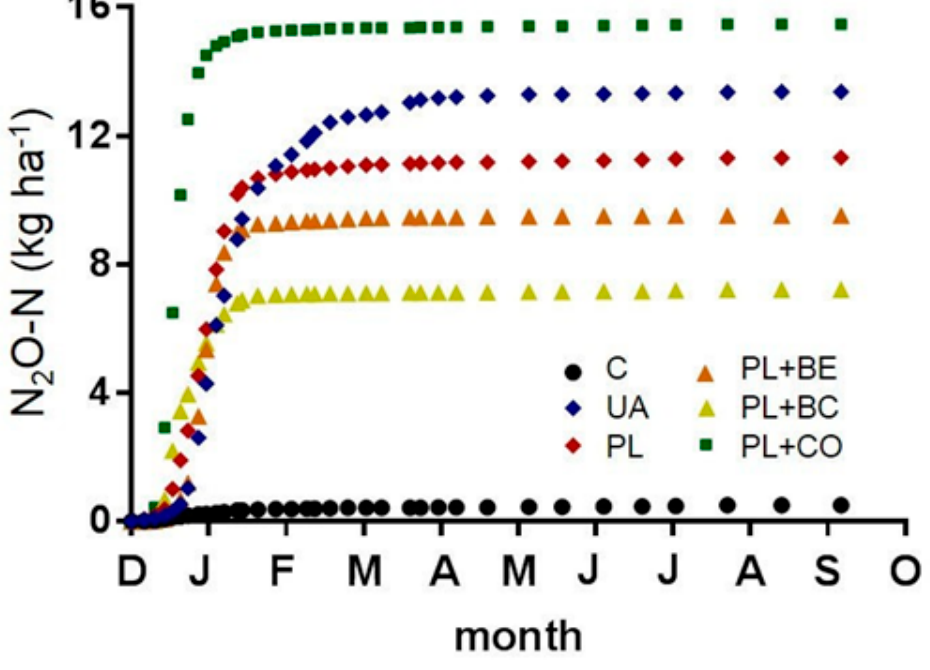
Figure 4. Mean cumulative N 2 O fluxes (kg ha kg − 1 ; n = 3) at the experimental field site from December 2014 to September 2015. C control (no N added), UA urea mineral fertiliser, PL poultry litter, PL + BE poultry litter + bentonite, PL + BC poultry litter + biochar, PL + CO poultry litter + compost. LSD at p < 0.05 is